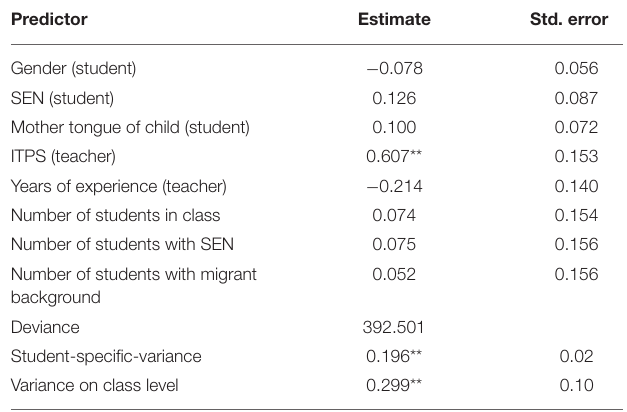
TABLE 5 | Estimates of the multi-level regression model analyses to predict teachers’ student-specific ratings (the third model).